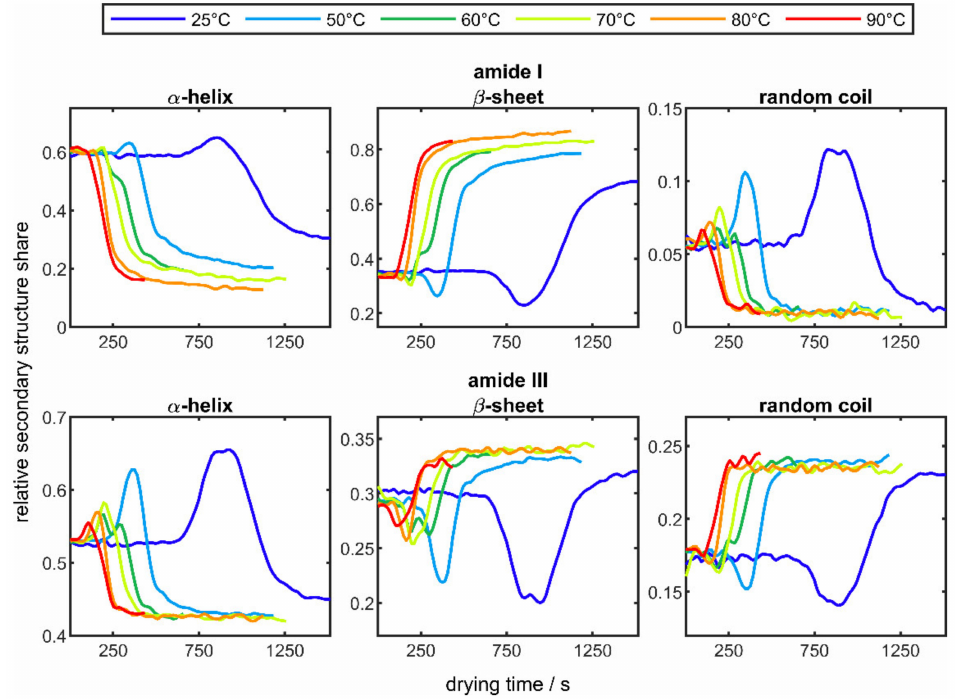
Figure 7. Averaged changes over time of the secondary structure elements α -helix, β -sheet, and random coil of poly-L-lysine in the amide I band ( top row ) and amide III band ( bottom row ) at different drying temperatures between 25 ◦ C (blue line) and 90 ◦ C (red